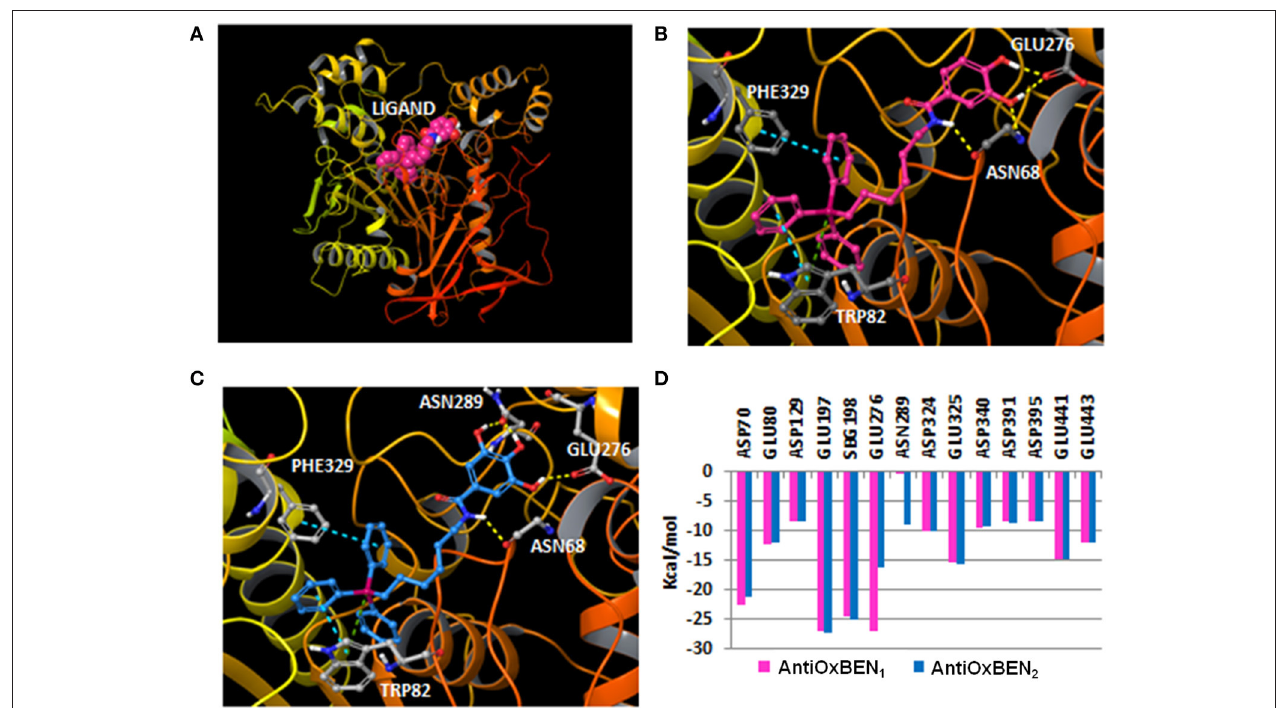
FIGURE 6 | (A) General perspective of AntiOxBEN 1 (CPK representation) bound to the BChE (ribbons) extracted from molecular docking; (B) Binding mode calculated with molecular docking for AntiOxBEN 1 (pink carbons) in the BChE (color code: yellow dashes for hydrogen bonds, blue dashes for π - π stacking interactions and green dashes for π -cation interactions); (C) Pose yielded by docking for AntiOxBEN 2 (blue carbons) in the BChE; and (D) Coulomb residue contributions to the binding between the BChE and AntiOxBEN 1 and AntiOxBEN 2 .